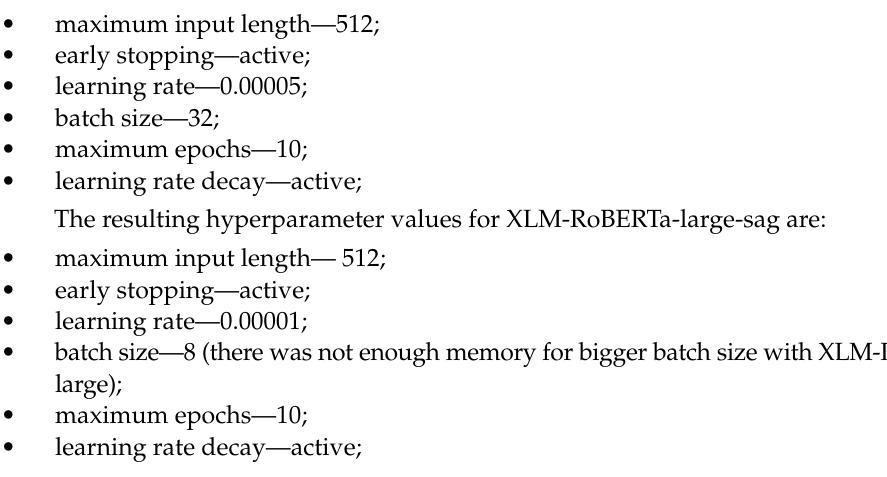
Text of target entities and text between them Text of target entities and the whole